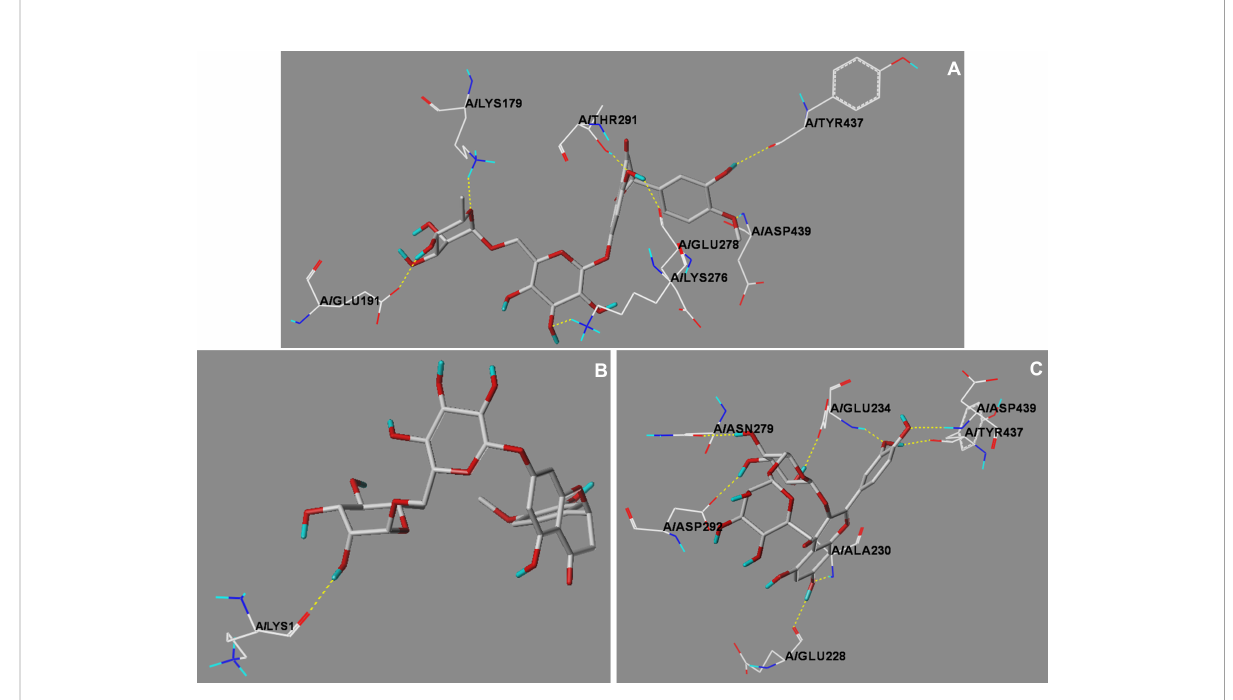
FIGURE 7 The hydrogen bonding plots of (A) AKT1-hesperidin, (B) CXCL12-hesperidi, and (C) AKT1-rutin. All ligands were depicted in a capped stick representation, while the interacting residues were shown as lines. The hydrogen bonds were yellow dashed